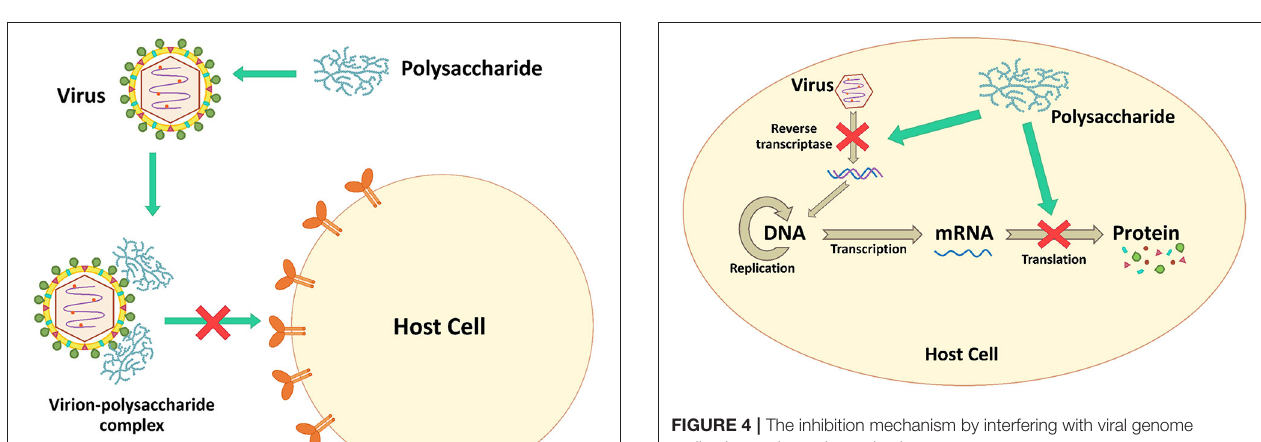
virus at ≥ 60% during virus adsorption and replication, while these polysaccharides were not effective at the virus release step.